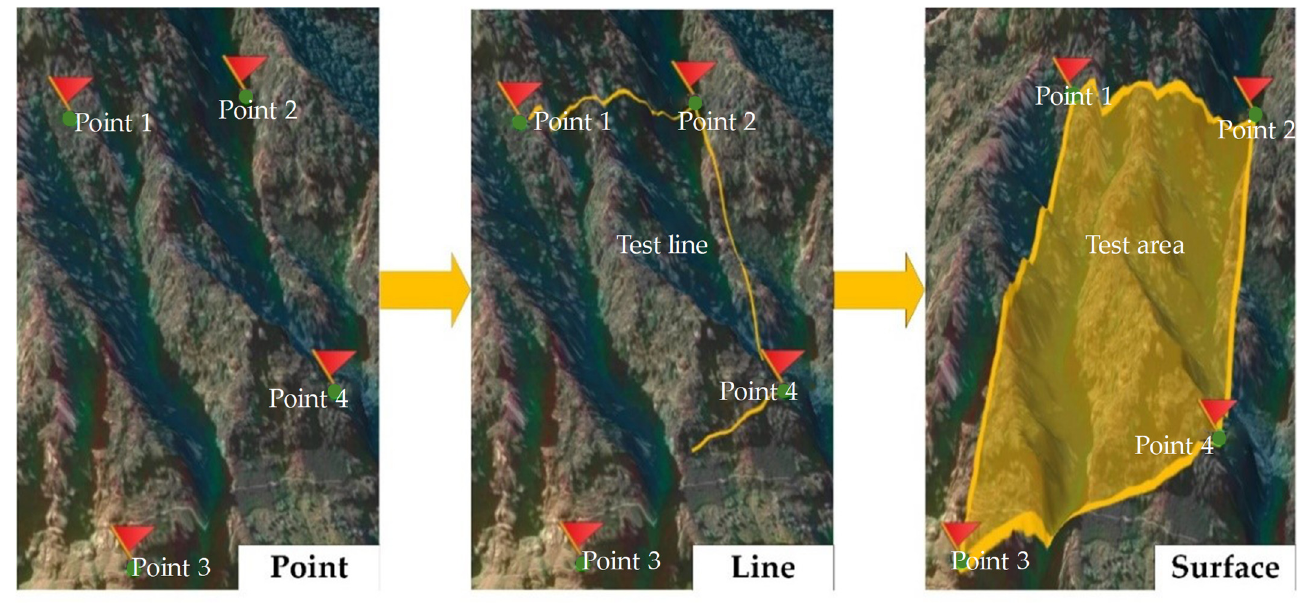
Figure 9. Object recording.